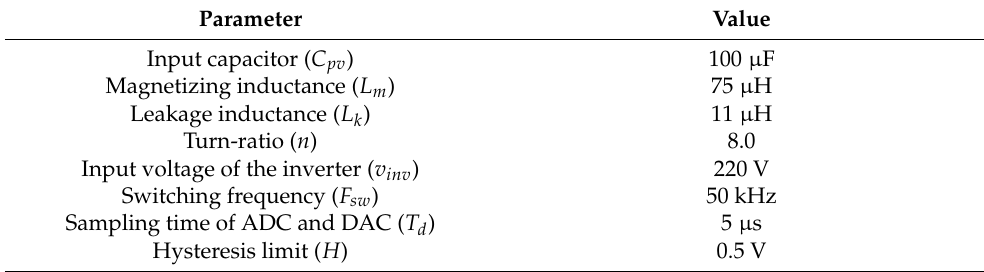
Table 2. Parameters for the PV